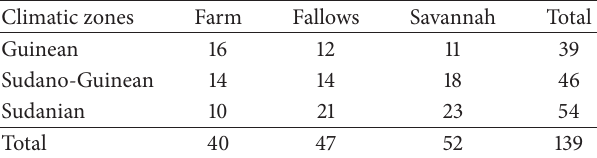
Table 1: Plots distributions according to ecological zones.